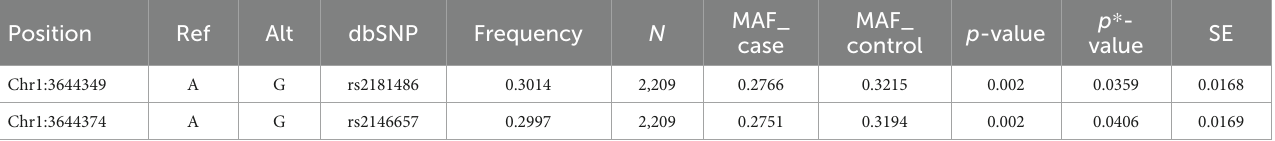
TABLE 2 Association analysis for the two common variants achieving statistical significance in the TP73 gene. Position Ref